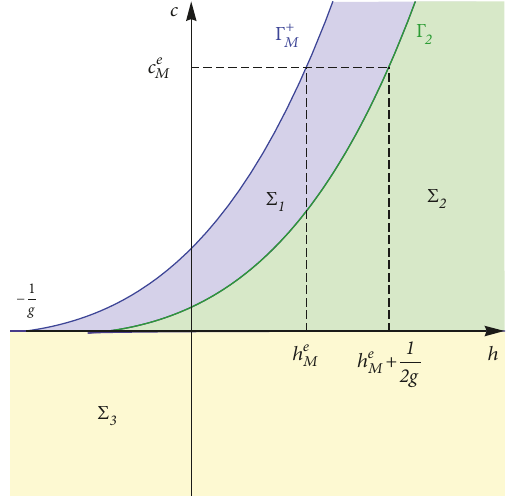
Figure3:Theimagesoftheequilibriumpoints (𝑁, 0, 𝑃) throughthe energy-Casimir mapping: Σ 2 ∪ Σ 3 ( 𝑔 = 1, 𝑎 = 2, 𝑏 = 1